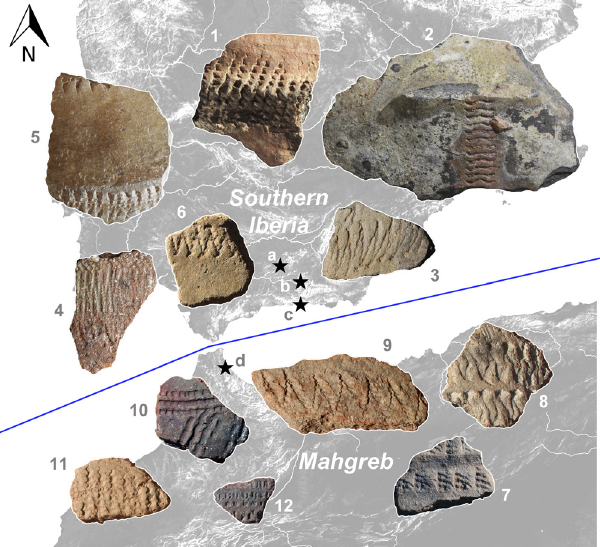
Figure 2: Some examples of impressed decorated potsherds from Andalusia ( 1 – 6 ) and Morocco ( Kaf That el Ghar ) ( 7 – 11 ) . Simple impressions and rocker with striated shell ( cardial and pecten impressions ) : ( 1 – 3, 6?, 7 – 9, 11 ) Rocker impressions with comb or multi - toothed instruments: ( 4, 5, 10, 12 ) . ( 1 and b ) Majolicas, Alfacar, Granada; ( 2 and c ) Cueva de las Campanas, Gualchos, Granada; ( 3, 6, and a ) Cueva de los Mármoles, Priego de Córdoba; ( 4 and c ) Zacatin Rockshelter, Castell de Ferro, Granada; ( 5 and c ) Cueva del Capitán, Lobres, Granada; ( 7 – 12 and d ) Kaf Taht el Ghar Cave ( Tetouan )